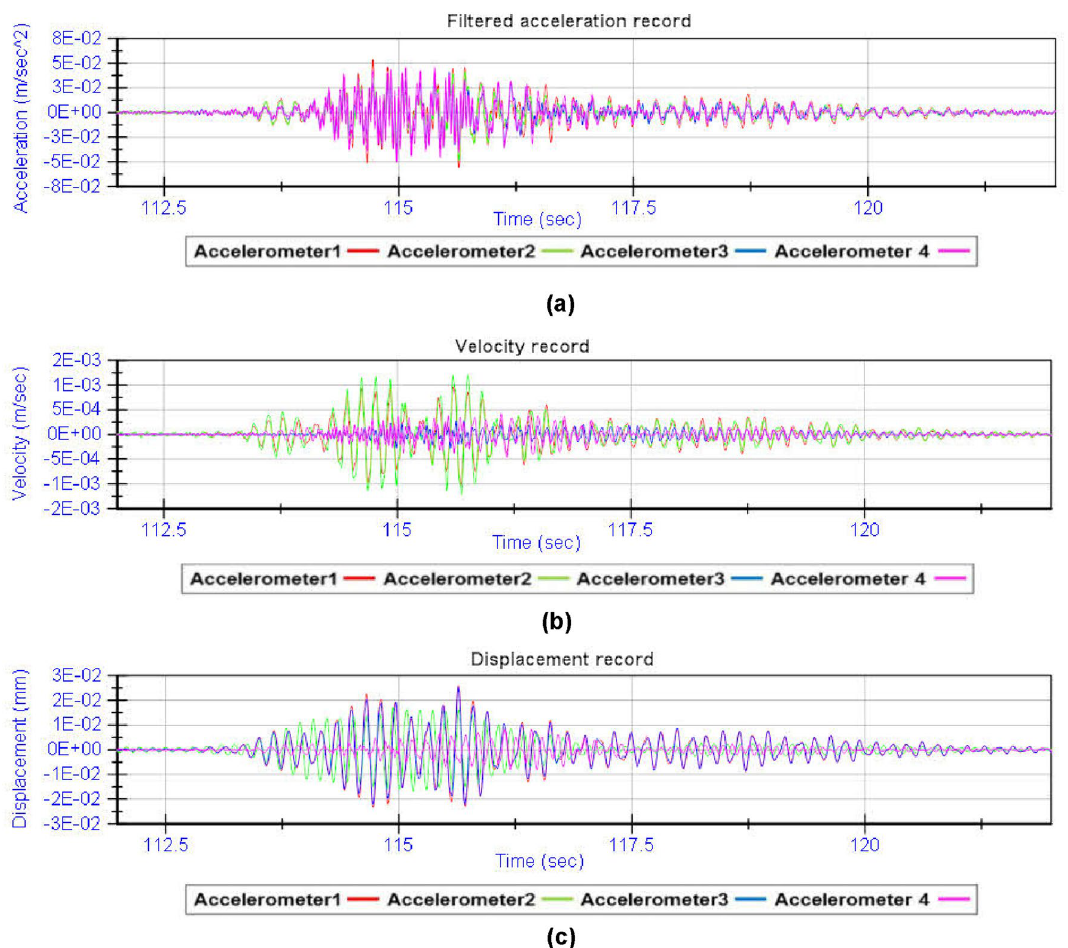
Figure 15. Acceleration filtering and numerical integration: ( a ) filtered acceleration record; ( b ) velocity record; ( c ) dynamic displacement